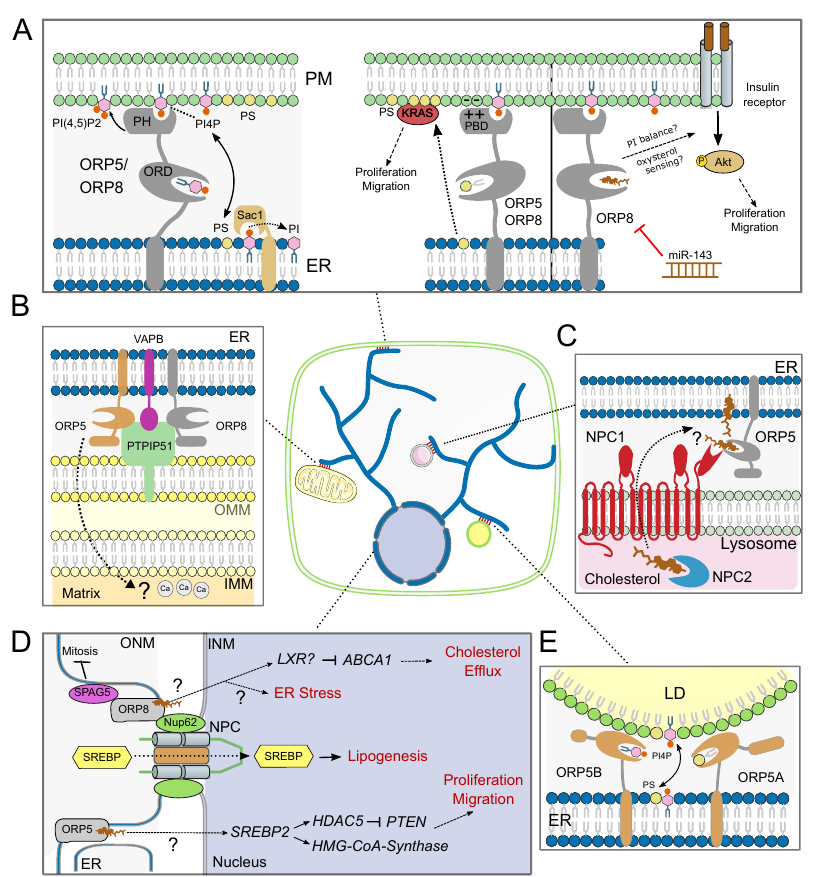
Figure 2. ORP5 and 8 function at various membrane contact sites. ( A ) Endoplasmic reticulum-plasma membrane (ER-PM) membrane contact sites (MCS): ORP5 / 8 function as phospholipid lipid transfer proteins (LTPs) powered by a counter-flow mechanism, enriching PS at the PM in exchange for PI(4)P which is dephosphorylated in the ER by phosphatase Sac1. Both PI(4)P and PI(4,5)P2 recruit ORP5 / 8 to the PM through interactions with the PH and PB domains, and PI(4,5)P2 is possibly also transported. ORP5 / 8-mediated control of PM levels of PS and PIPs may regulate cellular proliferation and migration through the activation of kinases such as KRas and AKT. Sterol sensing may also play a role. ORP8 levels are regulated by miR-143. ( B ) ER-mitochondria MCS: ORP5 / 8 interact with the mitochondrial MCS tether PTPIP51 (recruited to MCS by interaction with vesicle-associated membrane protein B (VAPB)) and regulate mitochondrial respiration, morphology, and Ca 2 + signaling, potentially through PS enrichment; ( C ) ER-(endo)-lysosome MCS: ORP5 interacts with cholesterol transporter NPC1 and regulates delivery cholesterol from the limiting membrane to the ER. Whether ORP5 directly transports sterols remains to be confirmed; ( D ) ORP8 interaction with centrosomal protein SPAG5 inhibits mitosis. ORP8 interaction with the NPC protein NUP62 promotes sterol regulatory binding protein (SREBP) translocation to the nucleus, thereby promoting lipogenesis. ORP8 represses cholesterol transporter ATP binding cassette subfamily A member 1 (ABCA1) expression and cholesterol e ffl ux, potentially through liver X receptor (LXR). ORP8 expression also induces ER stress through a poorly defined mechanism. ORP5 promotes SREBP2 expression, inducing hydroxymethylglutaryl coenzyme A (HMG-CoA)-synthase and histone deacetylase 5 (HDAC5) expression, while reducing phosphatase and tensin homolog (PTEN). This axis potentially contributes to increased proliferation and migration. Whether sterol sensing plays a role in these functions remains to be verified; ( E ) ER-lipid droplet (LD) MCS: ORP5A and its shorter isoform ORP5B are recruited to LDs via their ORD, exchange PS and PI(4)P on the LD phospholipid monolayer, and control LD size. PBD: polybasic domain, OMM: outer mitochondrial membrane, IMM: inner mitochondrial membrane, ONM: outer nuclear membrane, IMN: inner nuclear membrane, NPC: nuclear pore